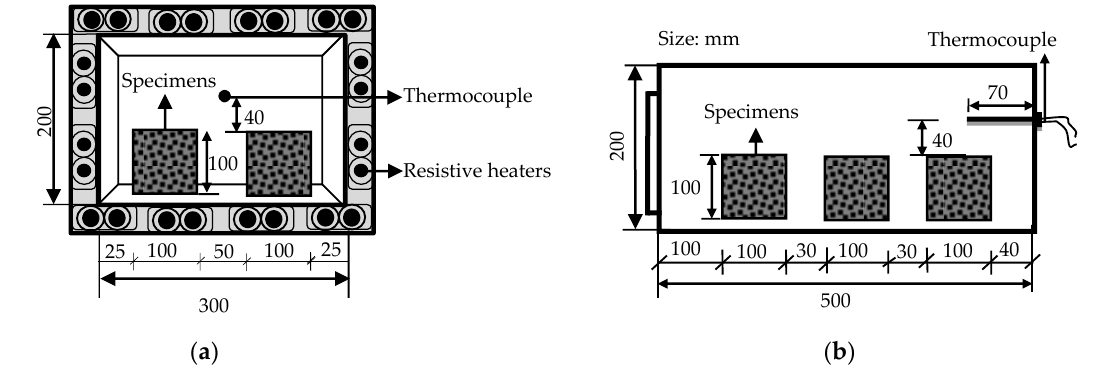
Figure 3. Heating setup for the explosive spalling test. ( a ) Front view; ( b ) lateral view.